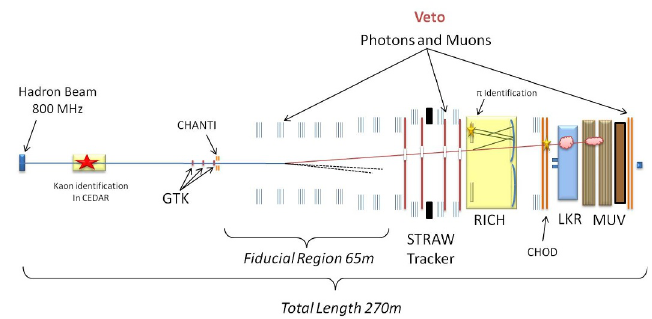
Figure 1. Layout of NA62 Experiment at